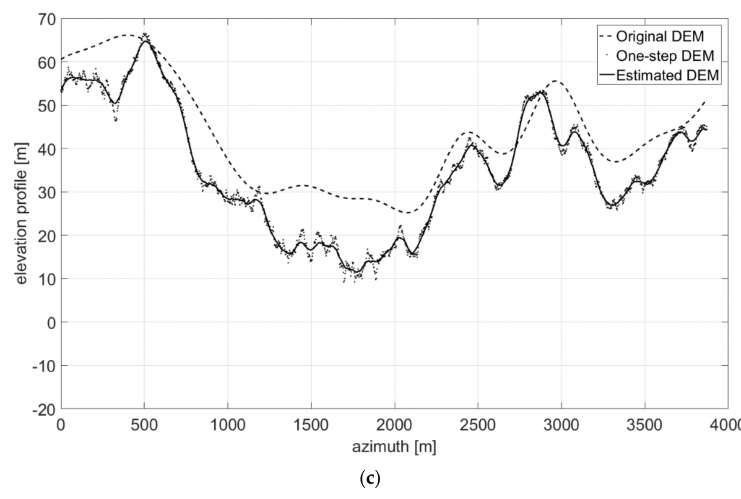
Figure 15. Comparison of original and estimated azimuth profiles assuming known starting points: ( a ) Lambertian vs fractal model; ( b ) unfiltered and ( c ) filtered case for the fractal model.